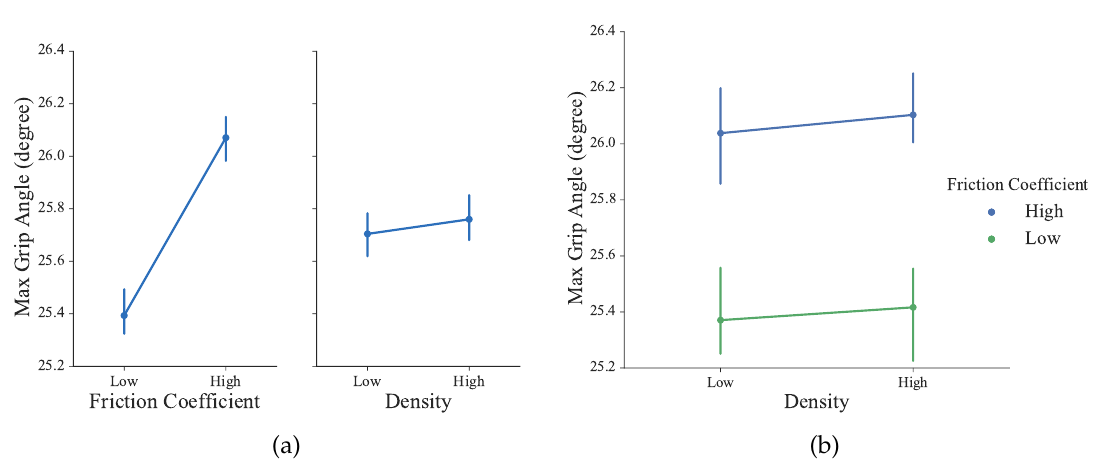
Figure 12. ( a ) Max grip angle of all subjects under four experimental conditions; ( b ) Max grip angle of all subjects across all conditions in the factor plot.